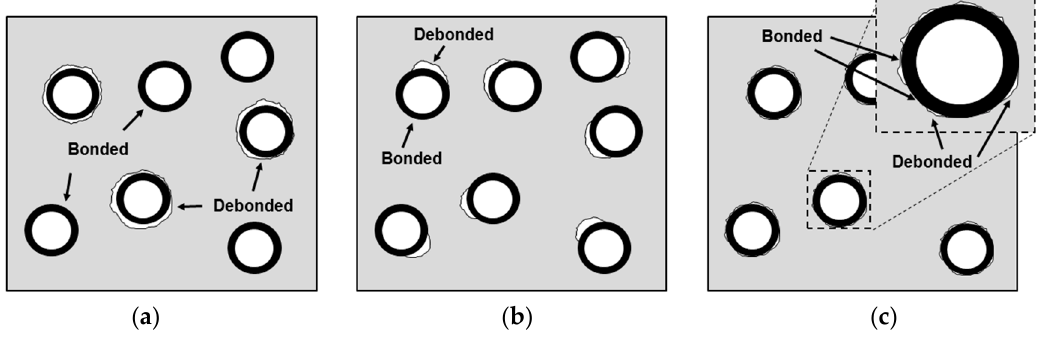
Figure 1. Schematics of debonding geometries for ( a ) the mixed model, ( b ) the partially debonded model and ( c ) the discontinuously bonded model.